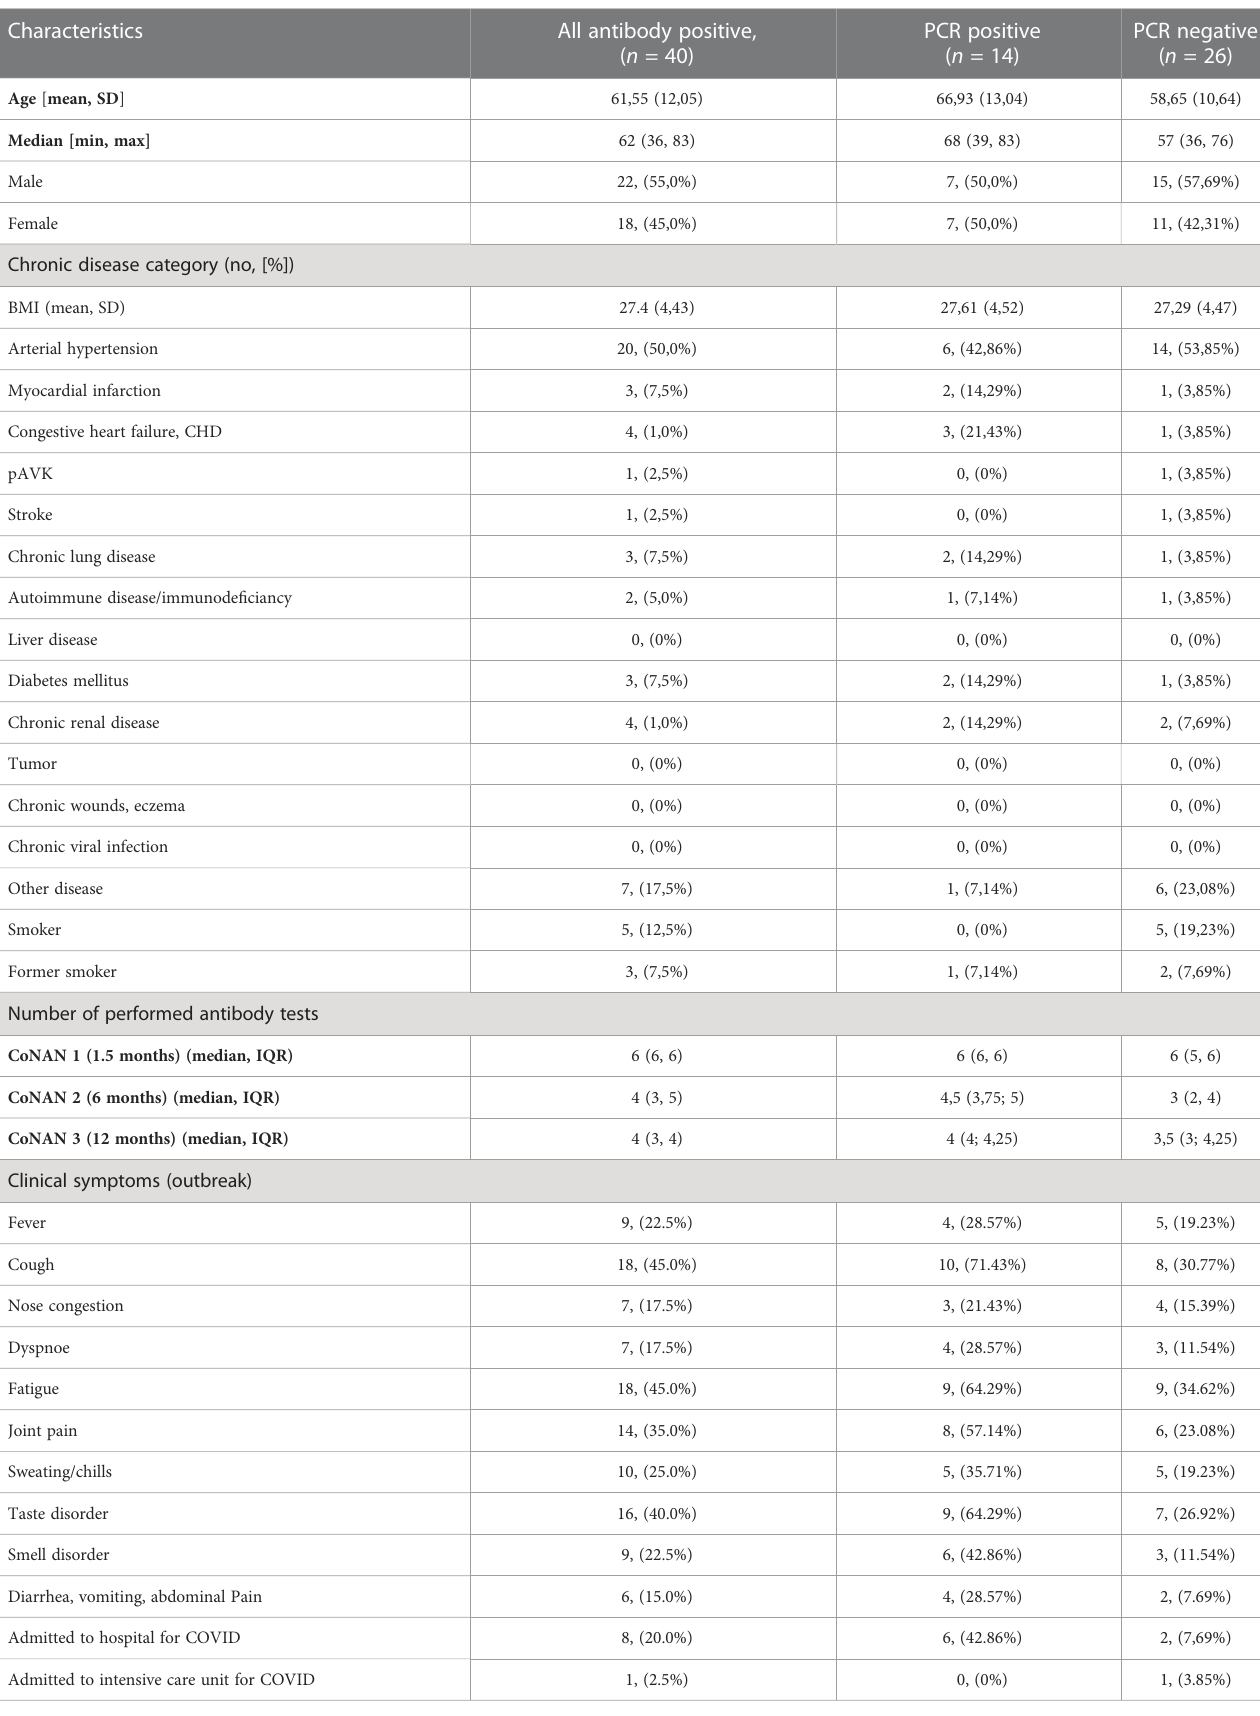
TABLE 1 Characteristics of the analyzed seropositive participants with matched samples from all three time points.